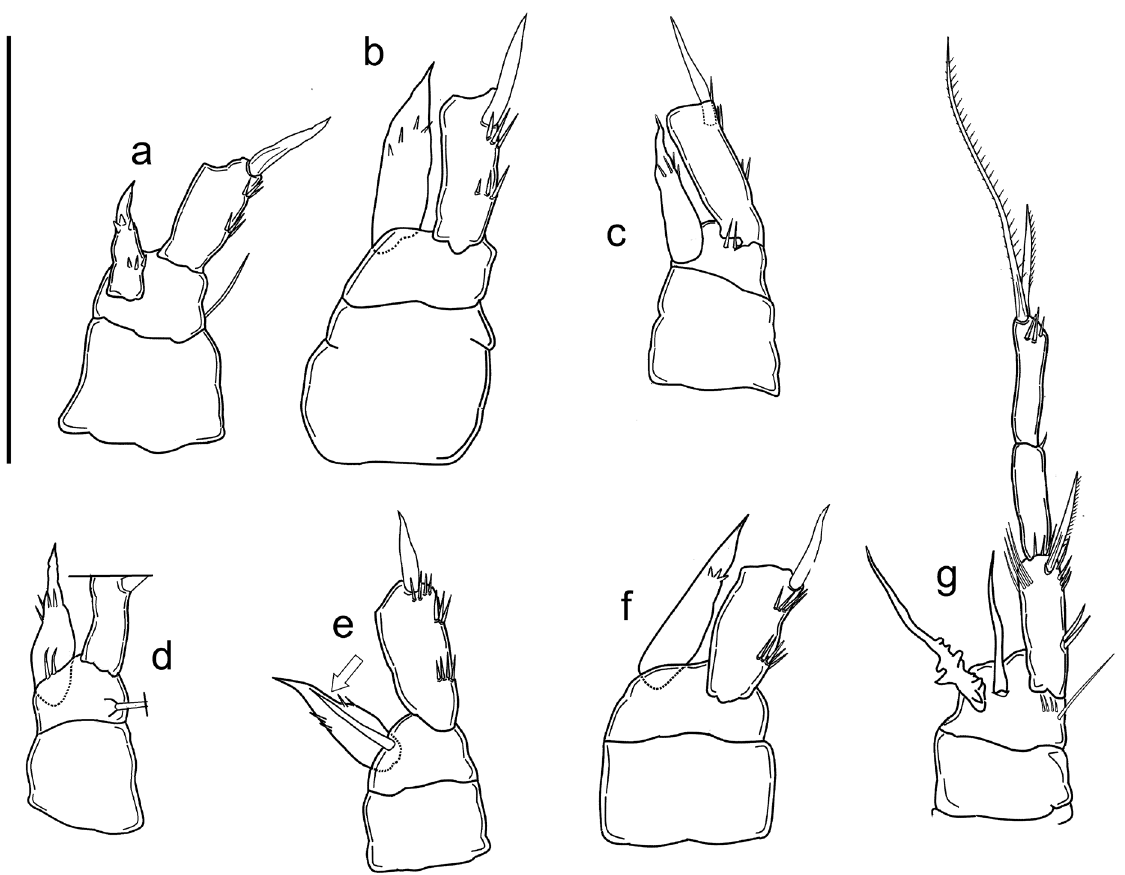
Fig. 16. a–f . ♂, copepodid V stage, P4 basis, first exopodal segment and enp. a . Proserpinicaris proserpina (Chappuis, 1938) (Bracciano Lake). b . Proserpinicaris admete (Cottarelli, Fasano, Mura & Saporito, 1980) (Sardinia). c – d . Proserpinicaris amalasuntae (Bruno & Cottarelli, 1998) (Bolsena Lake). e–f . Proserpinicari s sp. (Turkey), hyaline structure arrowed. g . Proserpinicari s sp. (Turkey), ♂, P4. Scale bar: 50